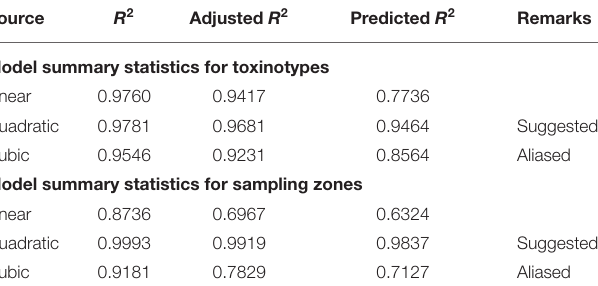
TABLE 9 | Summary statistics for responses used in CCD and BBD.